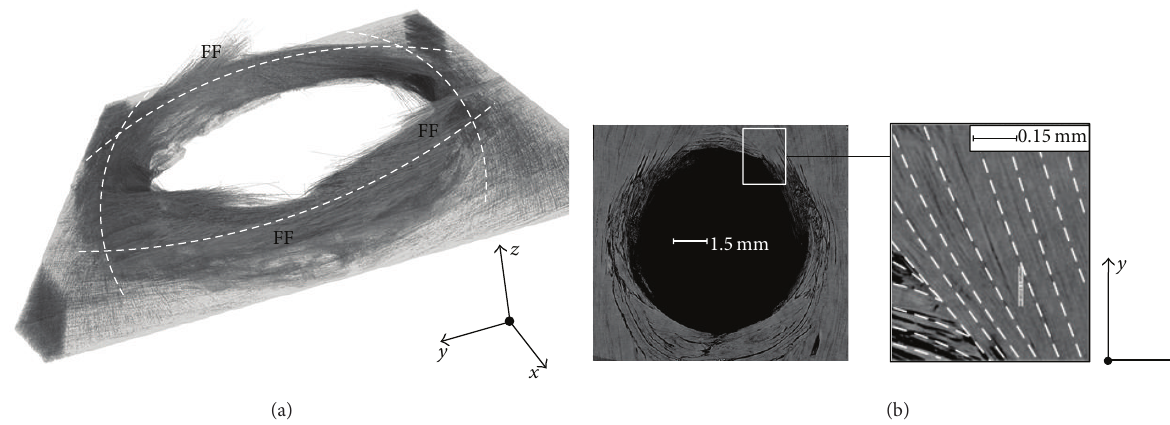
Figure 18: CT scan (voxel-resolution 4.8 𝜇 m) of hybrid joints: (a) three-dimensional view of GFRP with marked fiber orientations and (b) top view and detail view of CFRP edge with labeled fiber orientation.